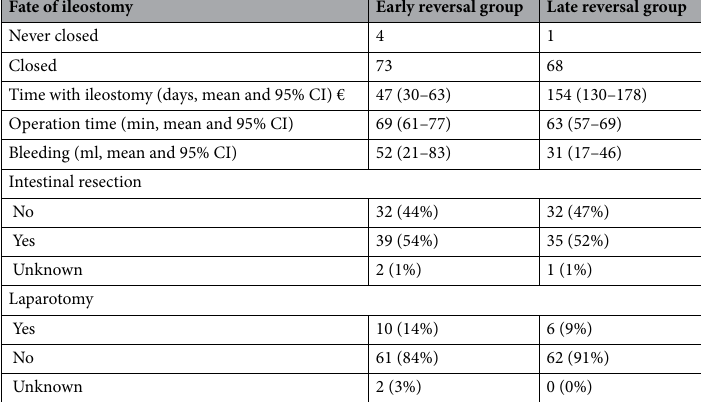
Early reversal N =